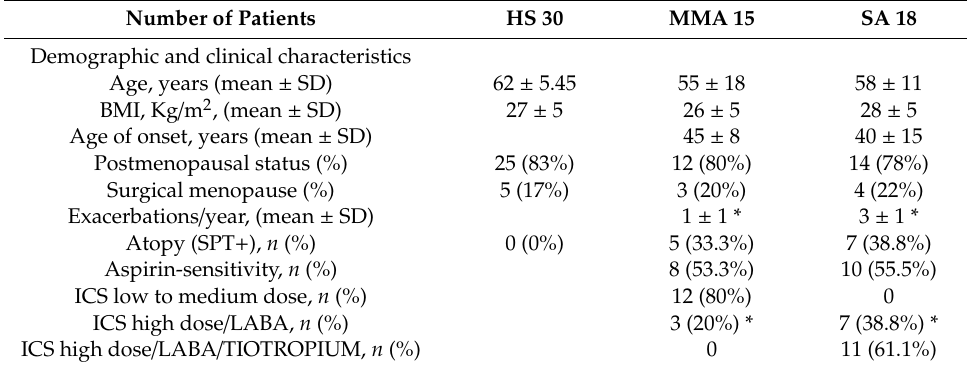
Table 1. Baseline characteristics of the study